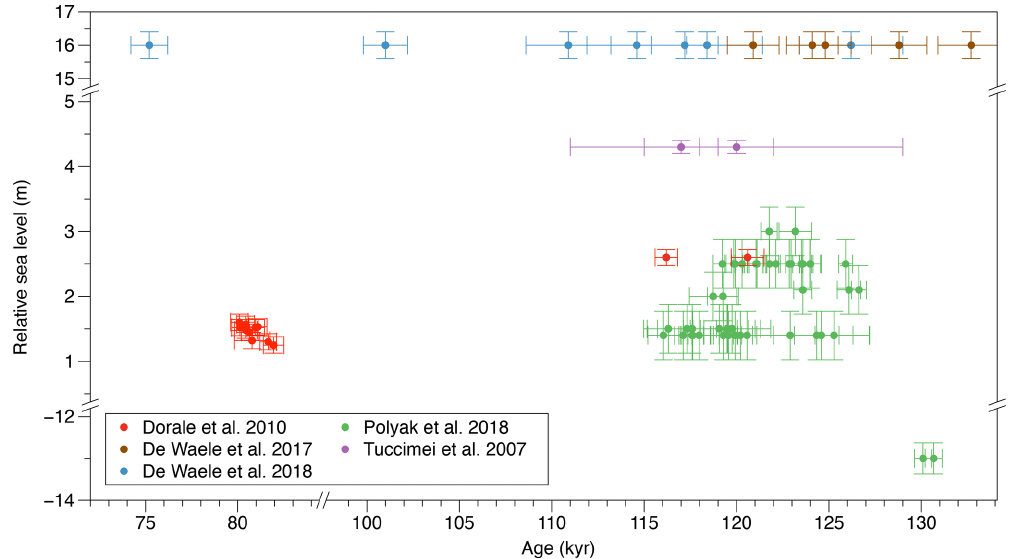
Figure 3. Paleo RSL position recorded by POS. Except for Tuccimei et al. (2007), all U–Th ages are corrected for detrital Th as per the original publications. No other corrections such as tectonic movement or GIA have been